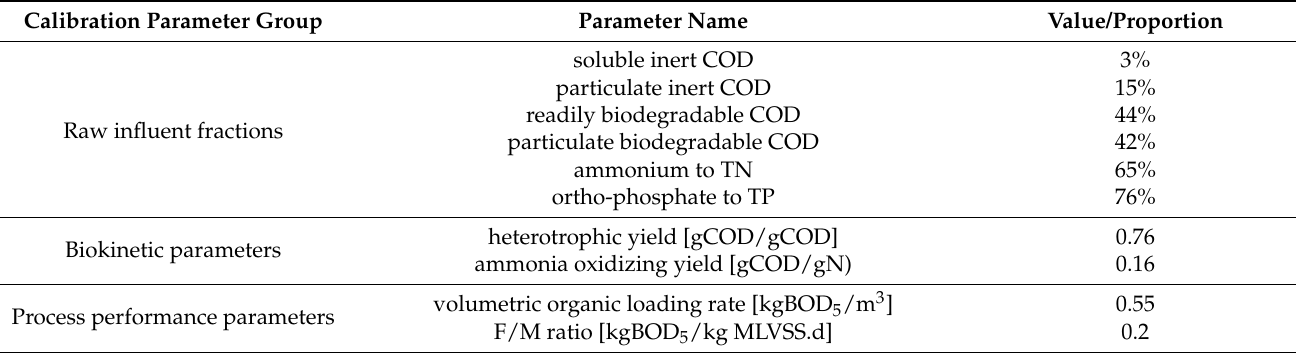
Table 3. Calibration